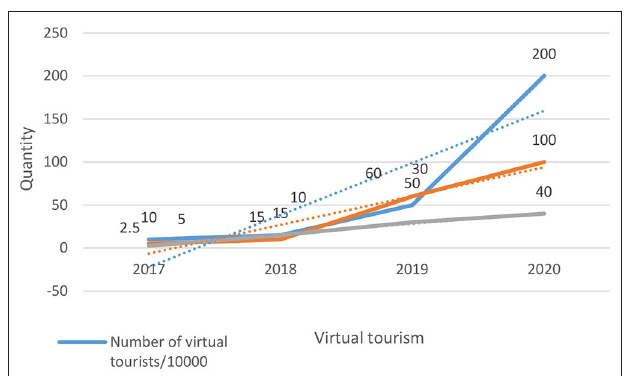
FIGURE 6 | Parameter selection for different